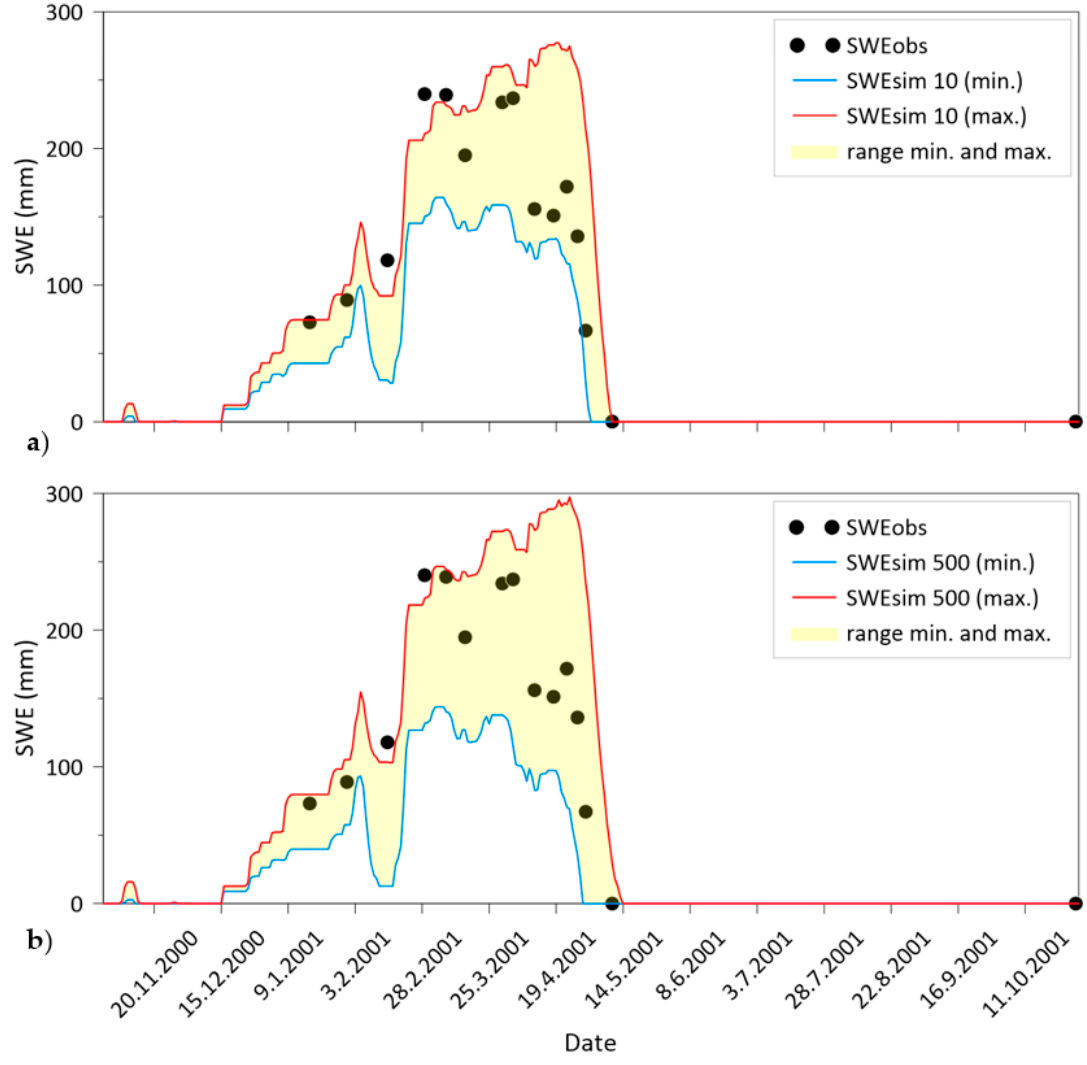
Figure 9. Measured snow water equivalent (SWE) at catchment mean elevation (points) and simulated catchment SWE after 10 (top panel) ( a ) and 500 repetitions ( b ). SWE is simulated in a snow richer validation period (2001–2006) with model parameters obtained in the snow poorer calibration period (1989–1994). The blue and red colours indicate min. and max. SWE values obtained by 10 and 500 simulations, respectively.